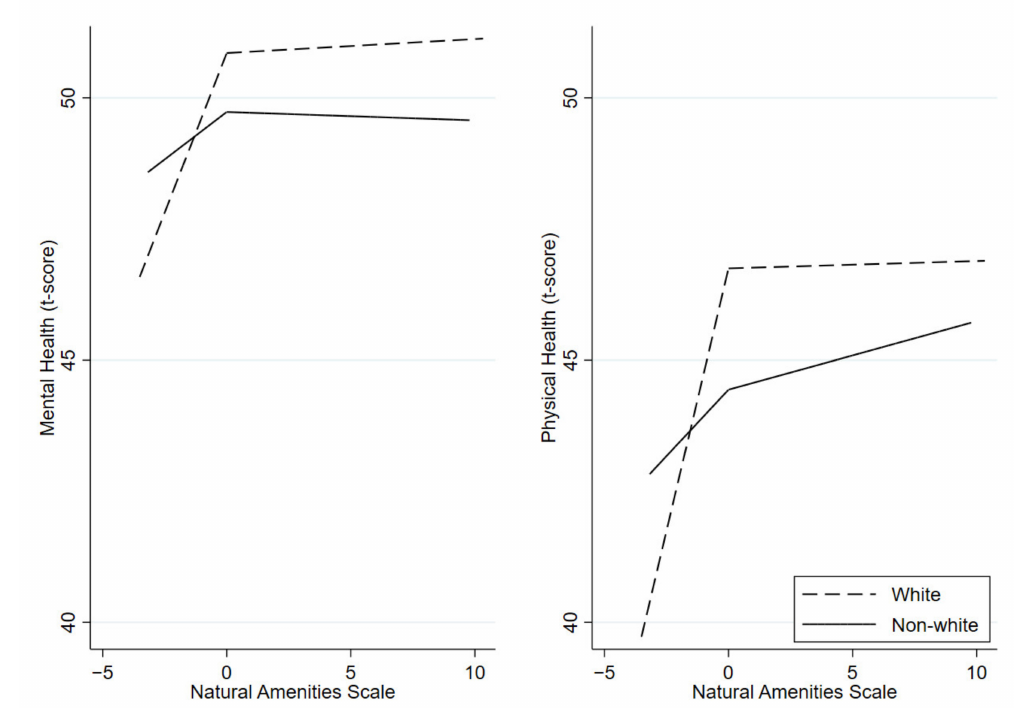
Figure 2. Unadjusted piecewise linear spline models visualizing the relationships between NAS and mental and physical health for White (dashed lines) and non-White (solid lines)